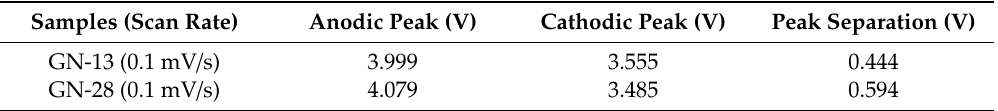
Figure 8. Electrochemical performance of NCM: ( a ) cyclic voltammograms (CV) test of GN-13; ( b ) the relationship lines between I P vs. ν 1/2 of GN-13; ( c ) CV test of GN-28; ( d ) the relationship lines between I P vs. ν 1/2 of GN-28. Table 1. Peak potentials obtained from the CV data of GN-13 and GN-28 at 0.1 and 0.5 mV/s.